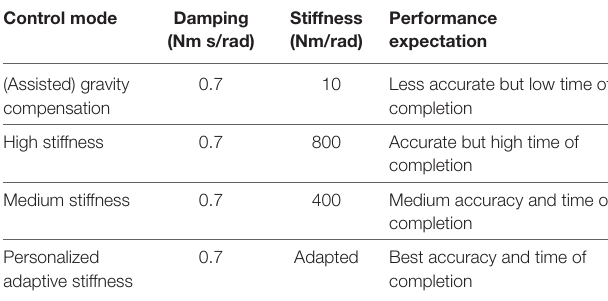
TaBle 1 | Overview of four control modes that are compared in the